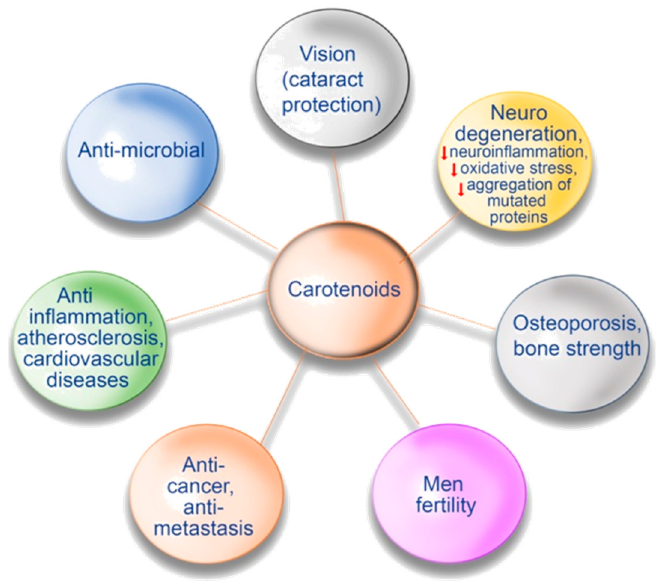
Figure 6. Possible positive effects of carotenoids on human health.